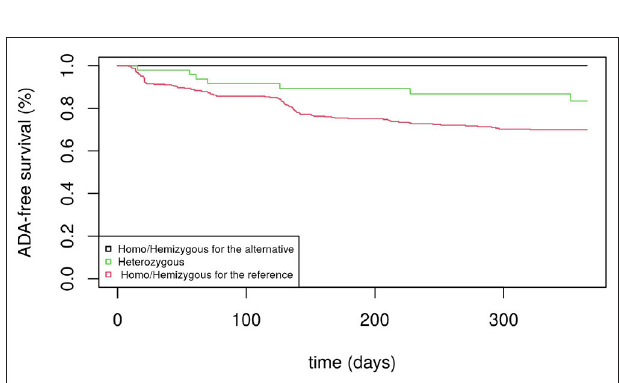
FIGURE 2 | ADA-free survival curves (men and women) for rs5991394.